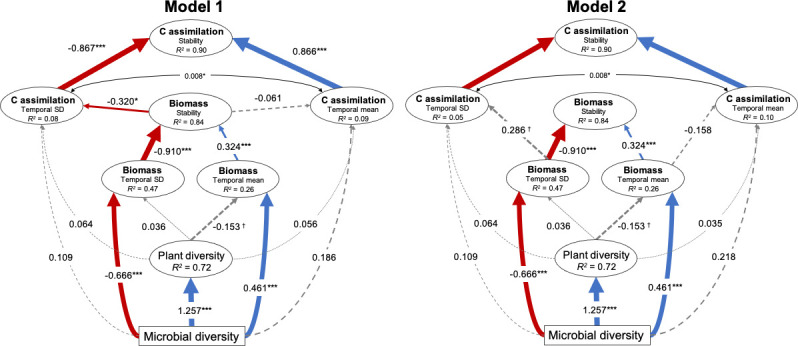
Structural equation model (SEM) results illustrating the direct and indirect effects of microbial diversity on the stability in plant biomass production and stability in soil carbon assimilation.The model assesses the effects of the temporal mean and variation of plant biomass production on the temporal mean and variation in soil carbon assimilation respectively. Red and blue arrows indicate negative and positive effects respectively, and the standardized coefficients for each are show adjacent. Non-significant effects are indicated by grey dashed lines. Significance is indicated by †p<0.1, *p<0.05, **p<0.01, ***p<0.001. The temporal mean and variation in soil carbon assimilation were allowed to covary, indicated by the black double headed arrow. The marginal R2 for each endogenous variable is provided (within ellipses). Model fit statistics: Chi-square = 18.3, p=0.107; RSEMA (Root Mean Squared Error of approximation) = 0.094, p=0.194; SRMR (Standardized Root Mean Square Residual) = 0.043, BIC (Bayesian Information Criterion) = −570.4. Microbial diversity is the scaled average bacterial and fungal richness. SEM results illustrating the direct and indirect effects of microbial diversity on the stability in plant biomass production and stability in soil carbon assimilation.